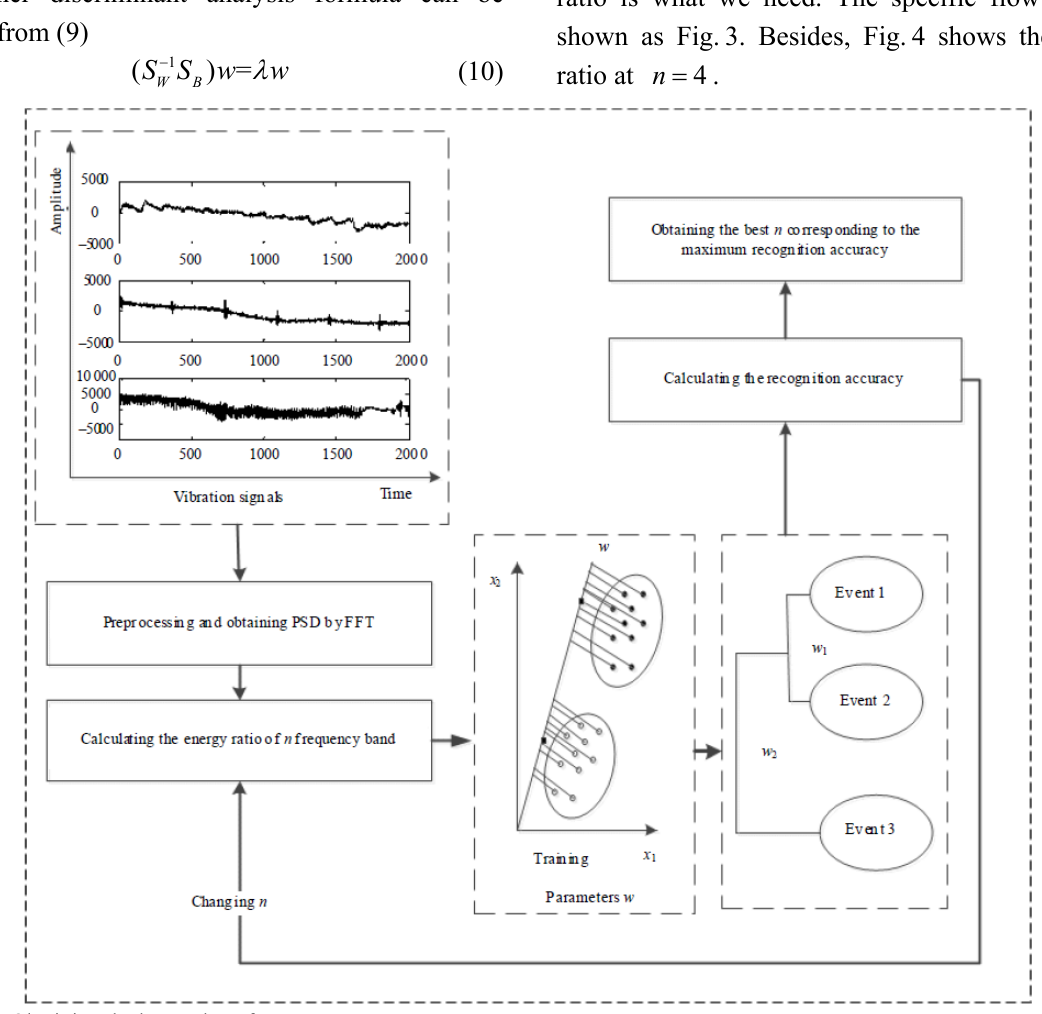
Fig. 3 Obtaining the best value of n